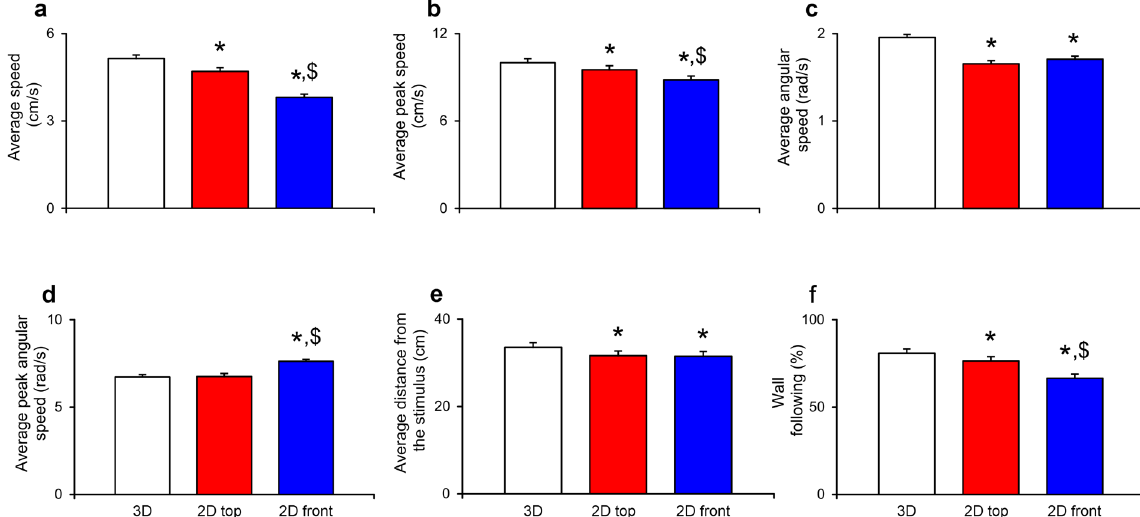
Figure 2. Comparison between 3D reconstructed trajectories and 2D top and front views. Group values of average speed, average peak speed, average angular speed, average peak angular speed, wall following, and average distance from the stimulus depending on the scoring method: “3D” represents the 3D reconstructed data, “2D top” represents 2D data acquired from the top camera, and “2D front” represents 2D data acquired from the front camera. Data were analyzed through repeated measures ANOVA for split-plot designs with condition as between-subject factor and scoring method as within-subject factor. Post-hoc comparisons were performed using Tukey’s HSD with a significance level of 0.05: * Identifies significant differences in comparisons with 3D measurements and $ identifies significant differences with 2D top views. Data are expressed as mean + standard errors. ( a ) Average speed values varied with the scoring method (n = 90; F 2,168 = 247.434, p < 0.001): 3D view yielded higher values compared to 2D top and front views; furthermore, 2D top view values were higher than 2D front view values. ( b ) Average peak speed values varied with the scoring method (n = 90; F 2,168 = 26.118, p < 0.001): 3D view yielded higher values compared to 2D top and front